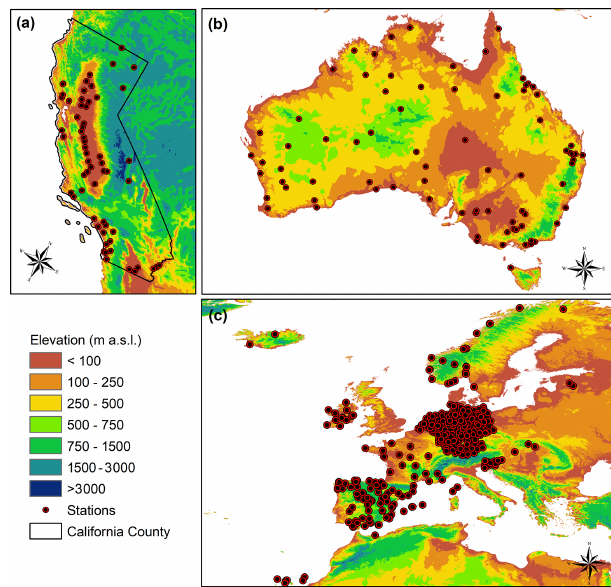
Figure 2. (a) The 60 stations in California from the CIMIS database, (b) 80 stations in Australia from the AGBM database, and (c) 385 stations in Europe from the ECAD